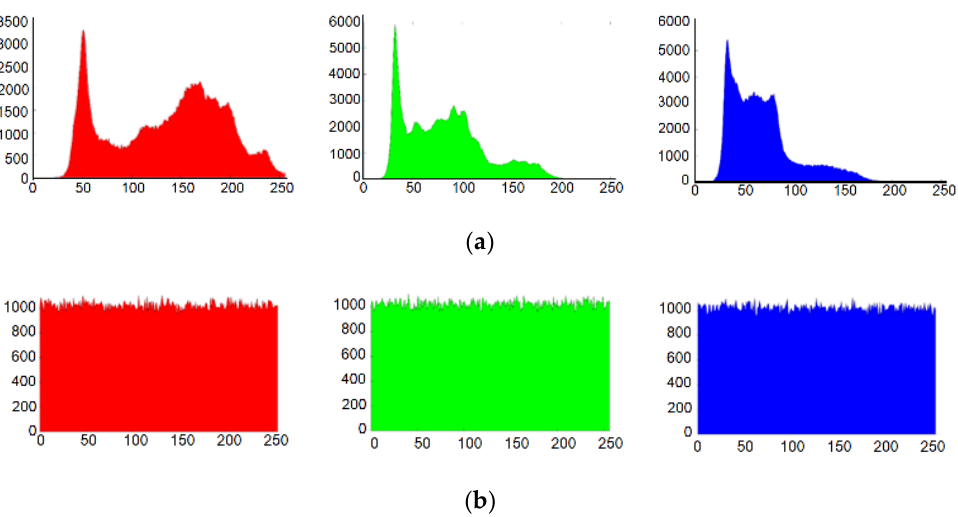
Figure 5. ( a ) Histograms of Lena.jpeg, ( b ) Histograms of Lena_encrypted.jpeg.